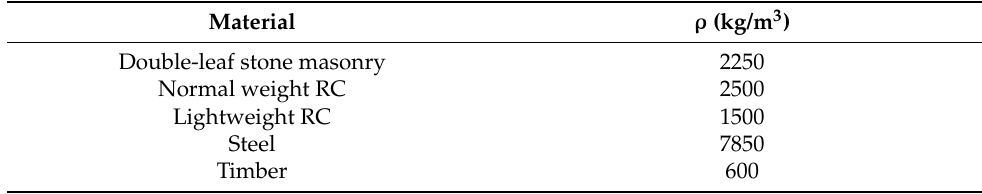
Table 2. Construction material densities.